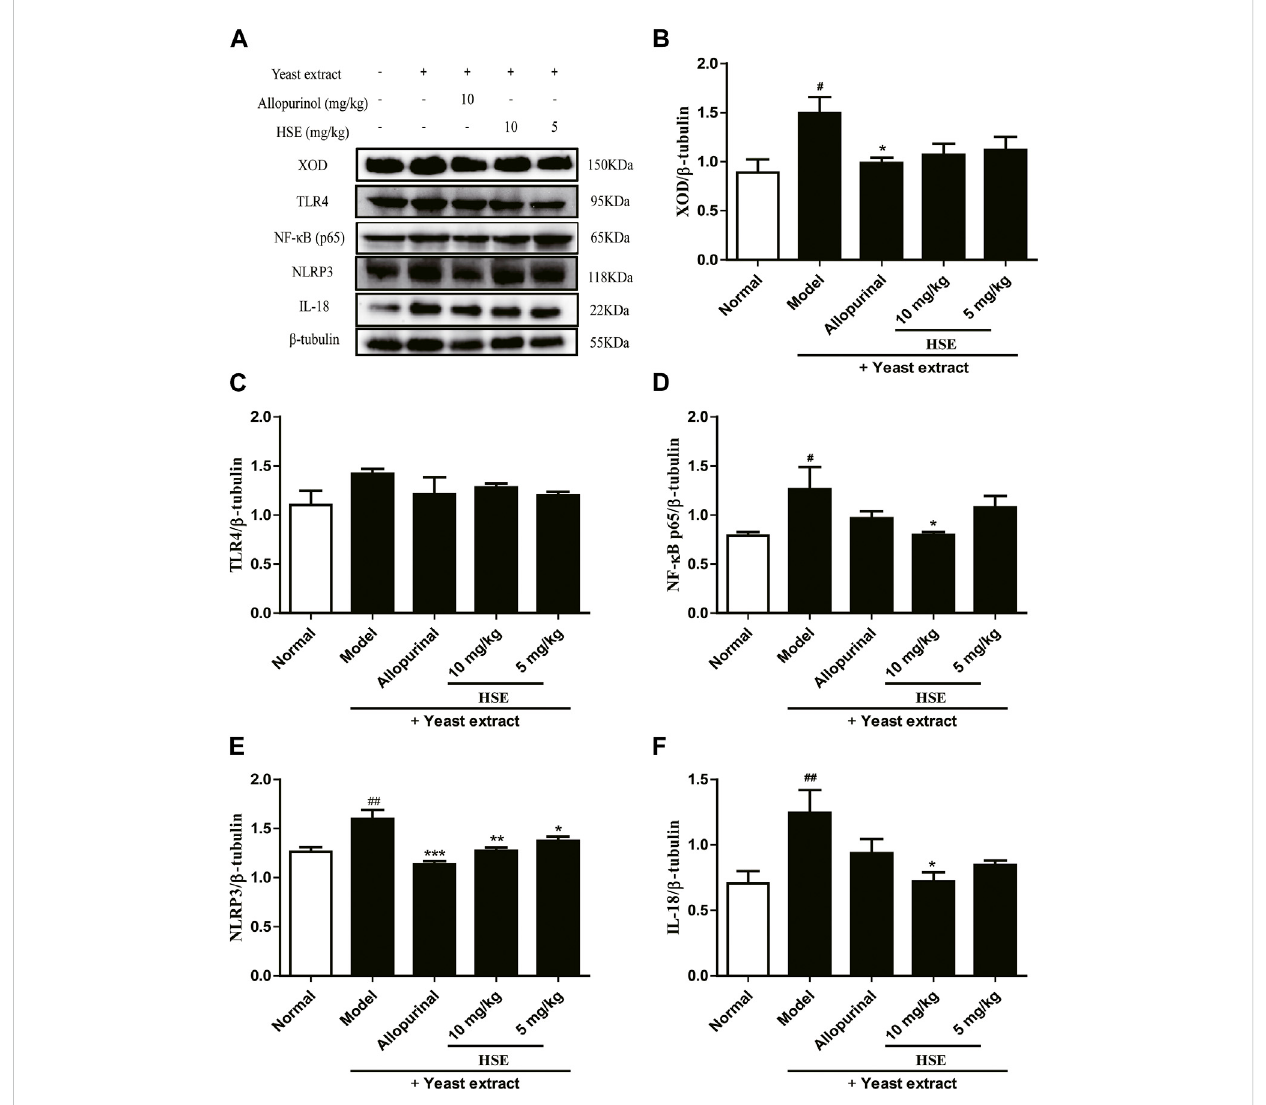
Effects of hesperetin (HSE) on protein levels in mice liver with hyperuricemia induced by yeast extract. Protein expression of XOD (B) , TLR4 (C) , NF- κ Bp65 (D) ,NLRP3 (E) ,IL-18 (F) and β -tubulinweredeterminedbyWesternblottingquanti fi edusingImageJ.Thedoseofallopurinolwas10 mg/kg invivo experiments.Dataarethemean±SEM(n=10). # p < 0.05and ## p < 0.01 versus thenormalgroup;* p < 0.05,** p < 0.01and*** p < 0.001 versus themodel group. HSE, hesperetin; XOD, xanthine oxidase; TLR 4: Toll-like receptor 4; NF- κ B p65: nuclear factor- κ B p65; NLRP3: nucleotide